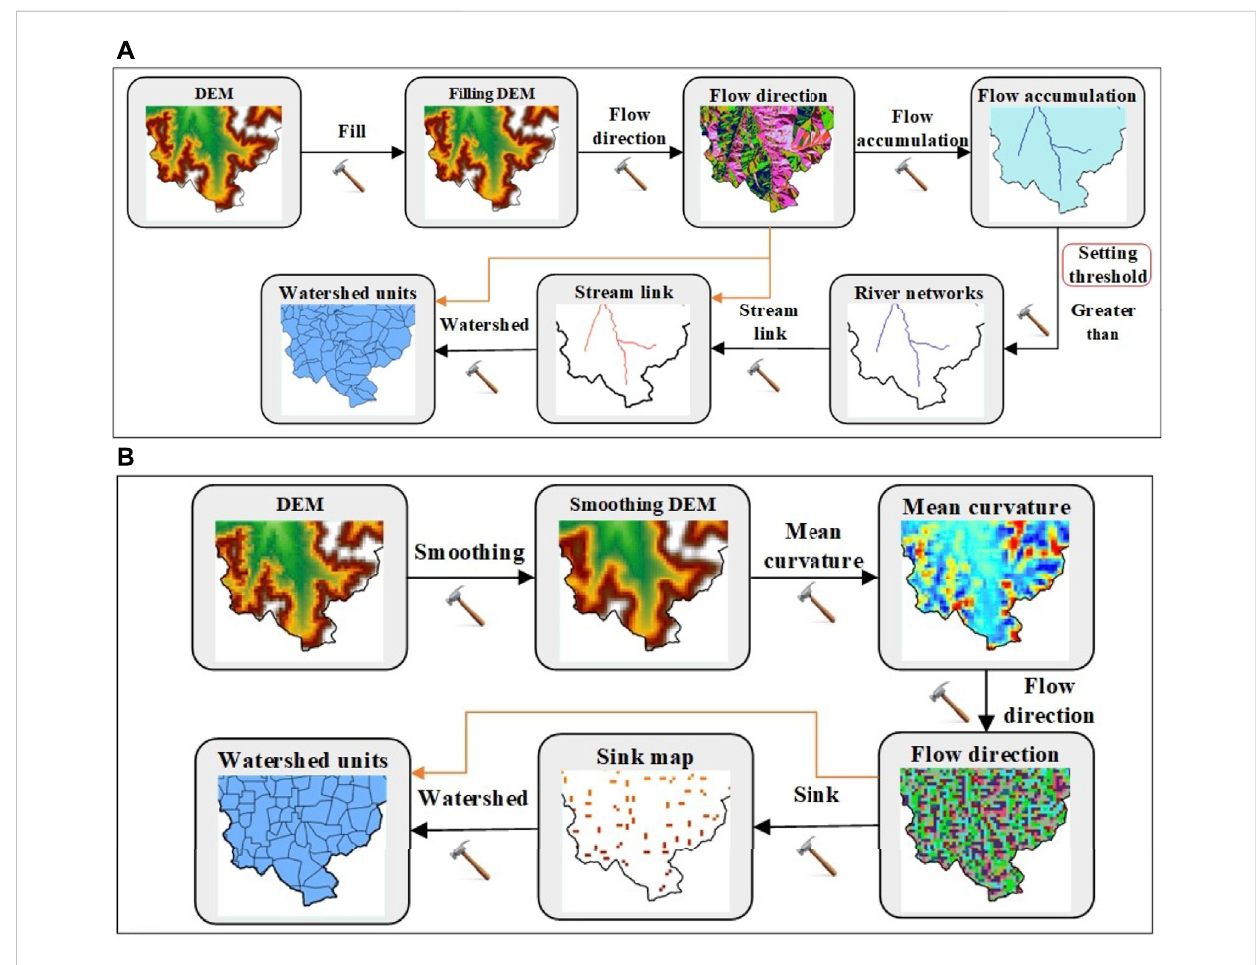
FIGURE 3 Classi fi cation process of the watershed units: (A) hydrological analysis method and (B) mean curvature method.